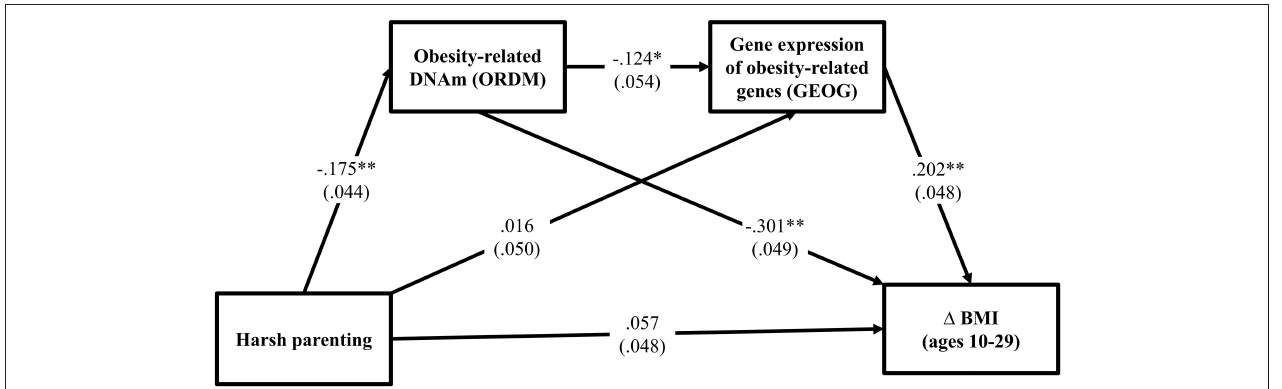
FIGURE 3 | Methylation and gene expression of obesity-related genes mediates the impact of harsh parenting on change in body mass index ( N = 362). Chi-square = 0.721, df = 2, p = 0.698; CFI = 1.000; RMSEA = 0.000. Values are standardized parameter estimates and standard errors are in parentheses. Genetic risk score for obesity, males, income, and unhealthy diet are controlled in these analyses. 1 = change in BMI from ages 10 (wave 1) to 29 (wave 7). ** p ≤ 0.01; * p ≤ 0.05 (two-tailed tests).